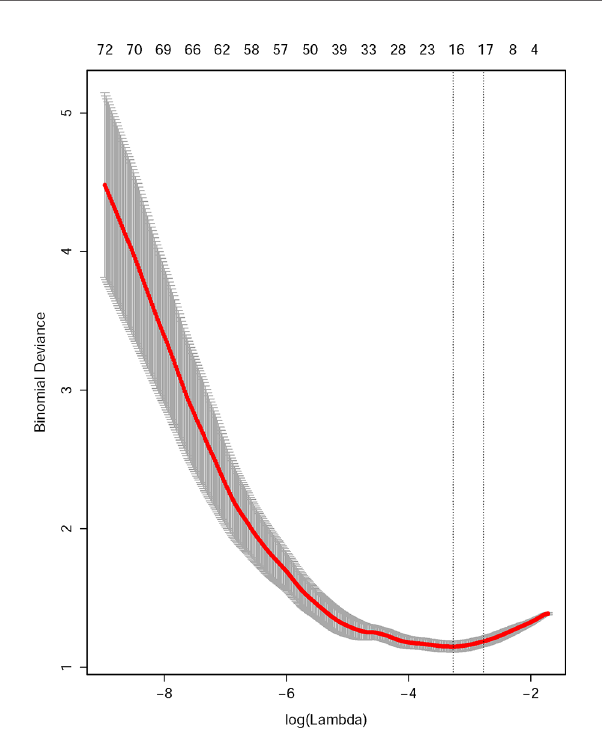
FIGURE 2 | Radiomics feature selection using the least absolute shrinkage and selection operator (LASSO) regression model. The 10-fold cross- validation (CV) process was repeated 50 times to generate the optimal penalization coef fi cient lambda ( l ) in the LASSO model. The value of l that produced the minimum average binomial deviance was used to select features. Dotted vertical lines were drawn at the optimal values using the minimum criteria and the 1 standard error of the minimum criteria (the 1-SE criteria). A l value of 0.043 was chosen (the 1-SE criteria) according to 10-fold CV, where optimal l resulted in 14 nonzero coef fi cients.